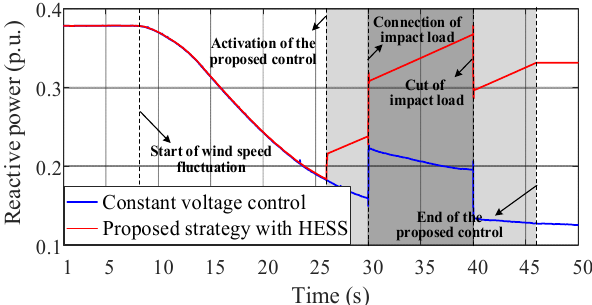
Figure 13. The output reactive power of the wind farm in case I .